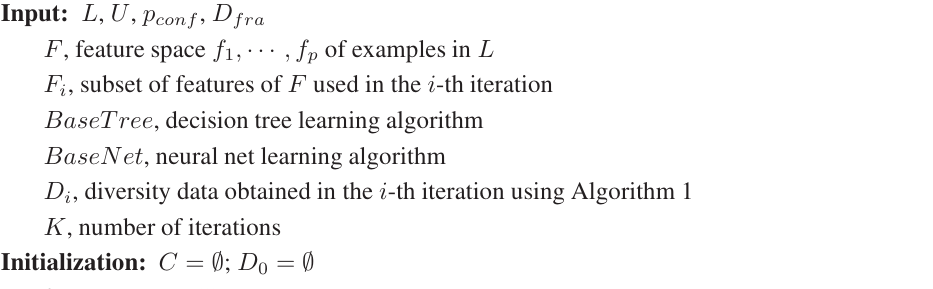
Algorithm 2 A semi-supervised co-training ensemble (SSCTE) learning algorithm.